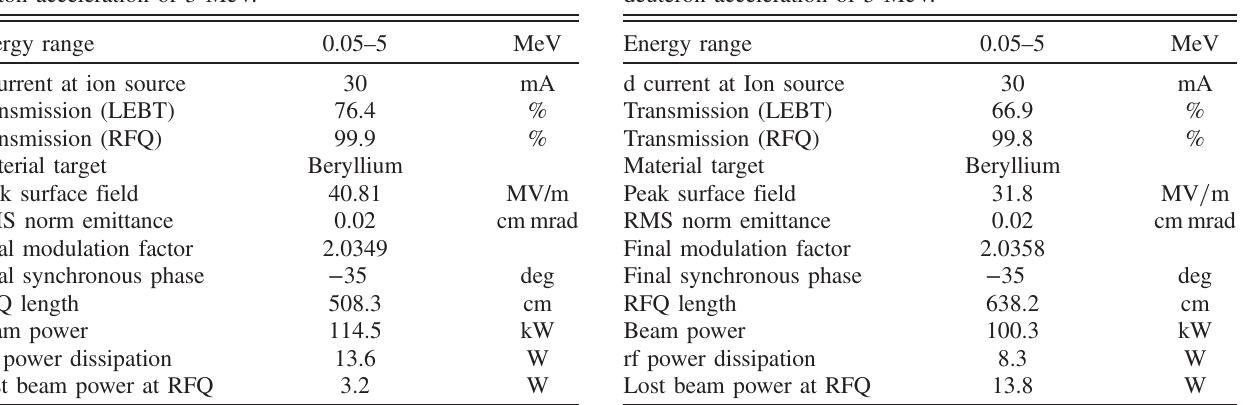
TABLE XIII. Conceptual design of SC-RFQ for BNCT with a deuteron acceleration of 5